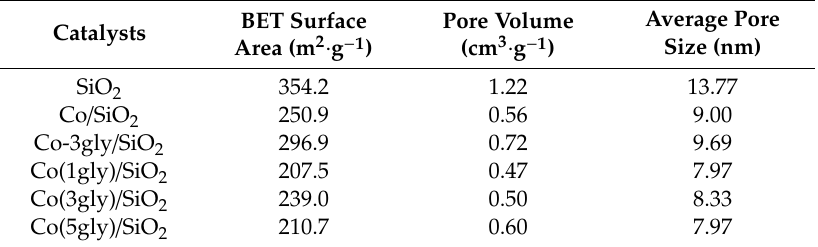
Table 1. Summary of the textural properties of the SiO 2 and catalysts.